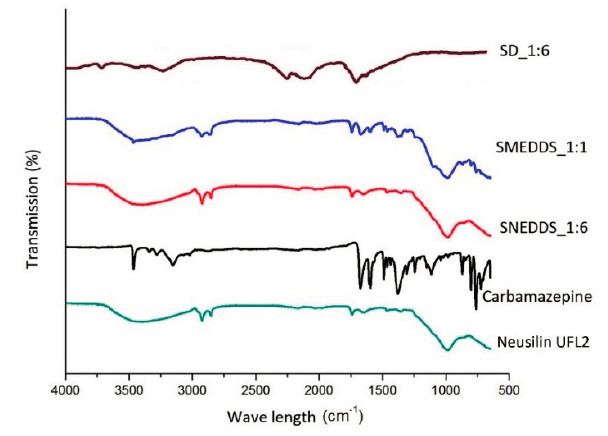
Figure 2. FT-IR spectra of evaluated formulations and pure carbamazepine.